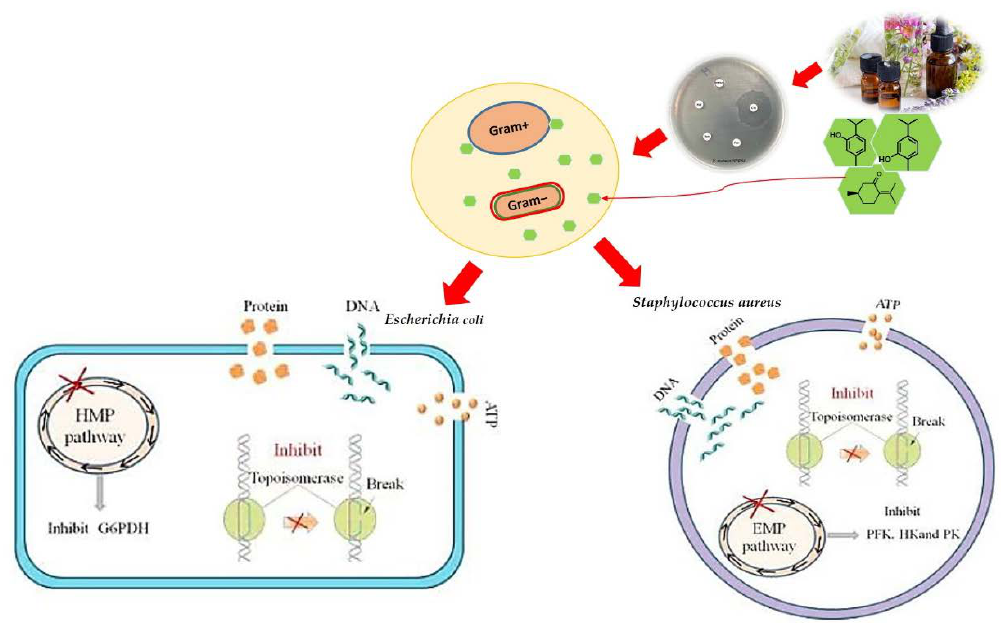
Figure 2. Mechanism of action of essential oils on Gram-positive and Gram-negative bacteria.